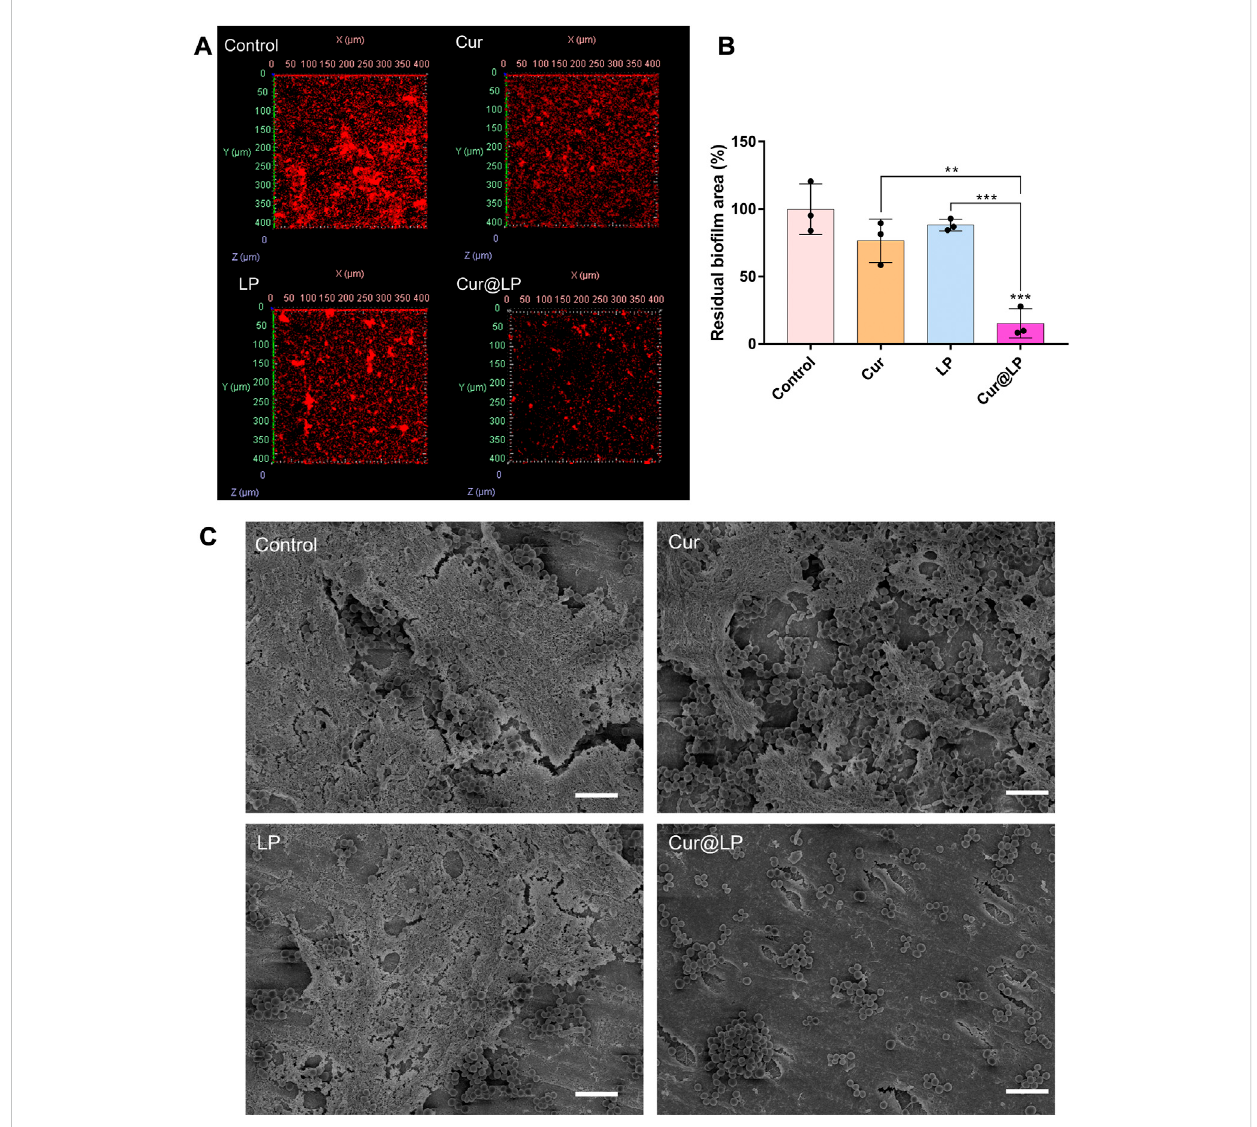
FIGURE 6 (A) Residual bio fi lm of S. mutans bio fi lm after treatment with PBS, Cur, LP, or Cur@LP for 4 h. The bio fi lms were stained red by STYO 59, and fi ve photos were taken for every sample. (B) Statistical analysis of the bio fi lm removal area. Three biological replicates are shown. (C) Residual bio fi lm of